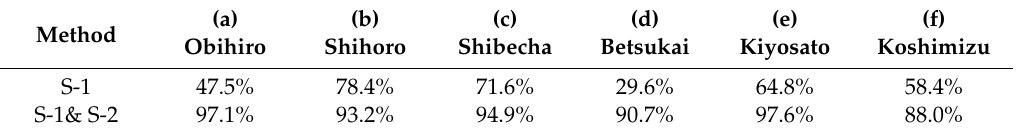
Table 3. Producer’s accuracies in each of the six “Not paddy” reference field regions in Hokkaido prefecture (30 m pixel-scale resolution). See Figure 2b for reference field region